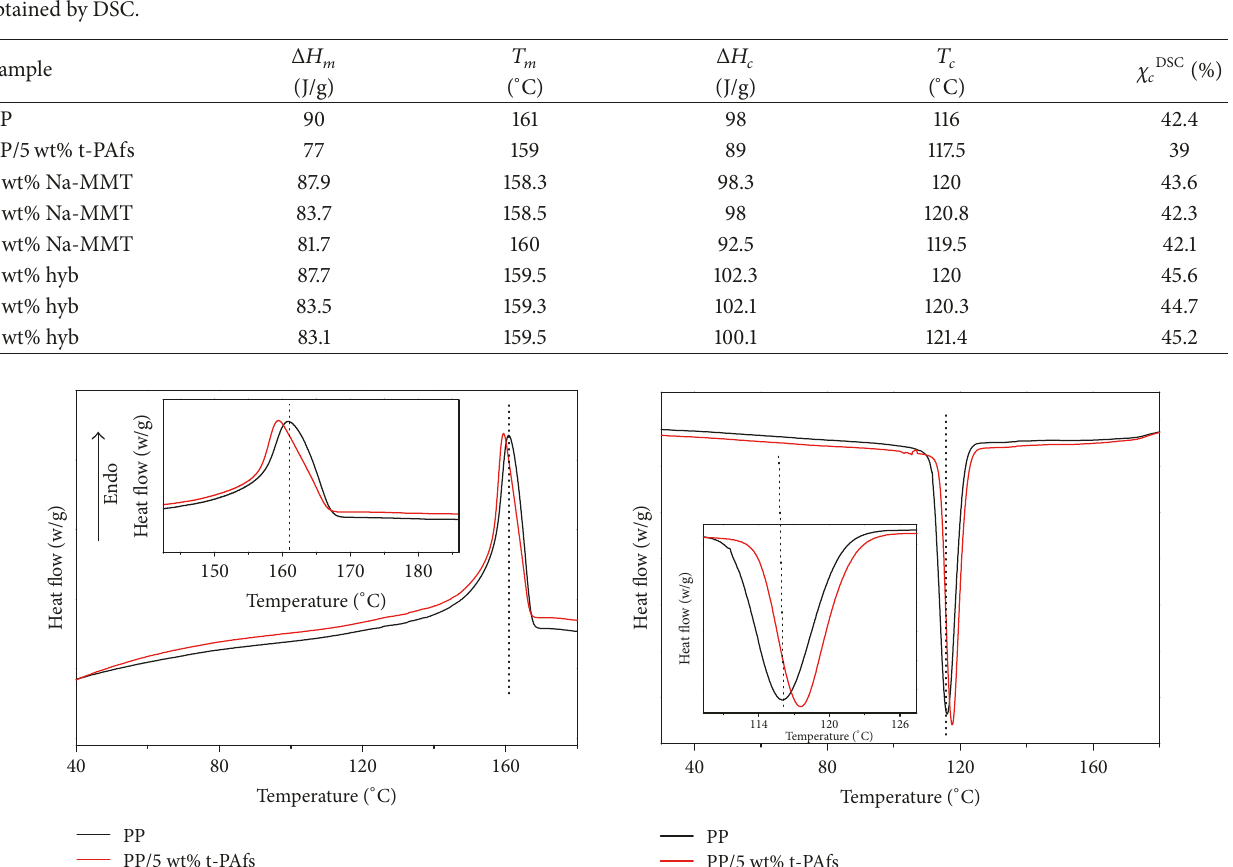
Figure 7: DSC thermographs of second heating and cooling runs of 5 wt% t-PAfs/PP